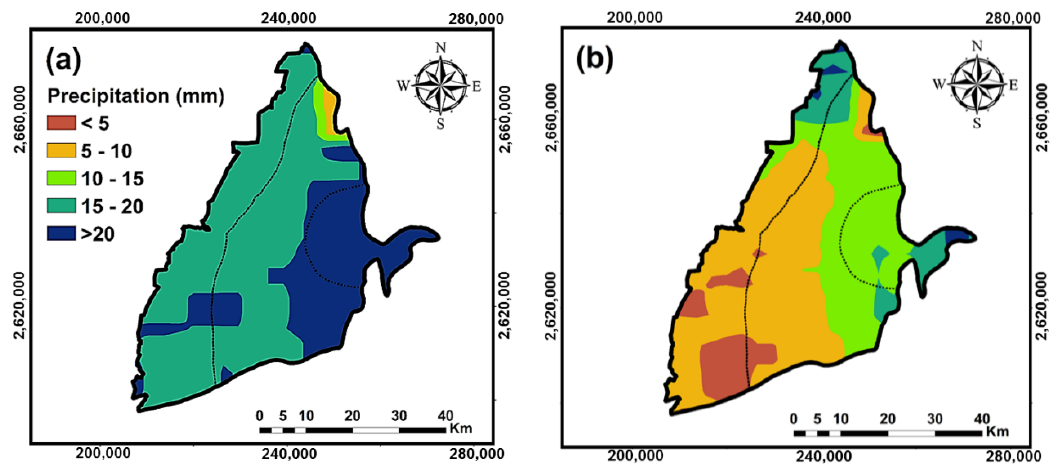
Figure 2. An example of the calculated Modified Precipitation (MoP) for January 2006: ( a ) the precipitation data for January 2006 based on original Climate Hazards Group InfraRed Precipitation with Station (CHIRPS) data, and ( b ) the MoP data calculated by adding the original CHIRPS data with the interpolated residuals obtained from the regression analysis between the rain gauge stations and the CHIRPS data.